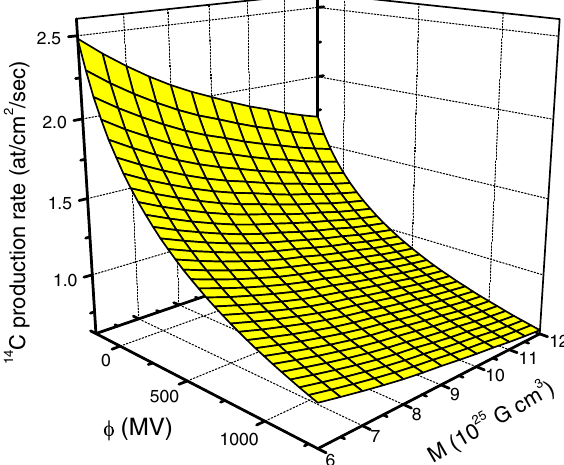
Fig. 10 Globally-averaged production rate of 14 C as a function of the modulation potential φ and geo- magnetic dipole moment M , computed using the yield function by Kovaltsov et al. (2012), LIS by Burger et al. (2000) and cosmic-ray–modulation model by Usoskin et al. (2005). Other models (Masarik and Beer 2009; Poluianov et al. 2016) yield a similar result